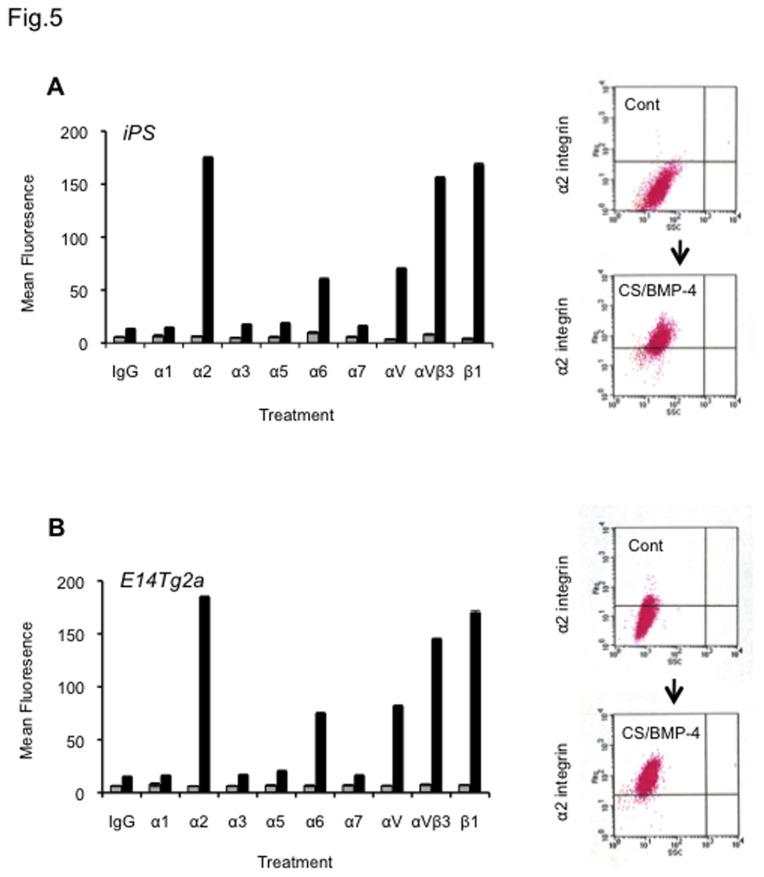
Flow cytometry analysis of integrin expression.Cells were cultured in the absence (control: grey bars) or presence (black bars) of CS (10% Col-I) and BMP-4 for 7 days in the presence of various anti-integrin monoclonal antibodies (as shown). Detection of the relevant secondary antibody was performed by flow cytometry to estimate the numbers of cells expressing each protein. Negative control values (secondary antibody alone) were subtracted from test values to give the mean fluorescence intensity. Data are mean ± SD (n=3).